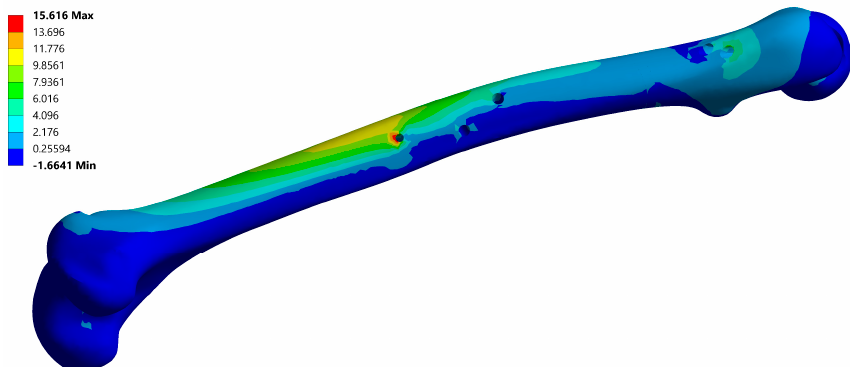
Figure 7. Maximum principal stress field of the femur, corresponding to instance no. 6 (Table 2). Maximal stress values are typically located on the anti-rotation screw hole.